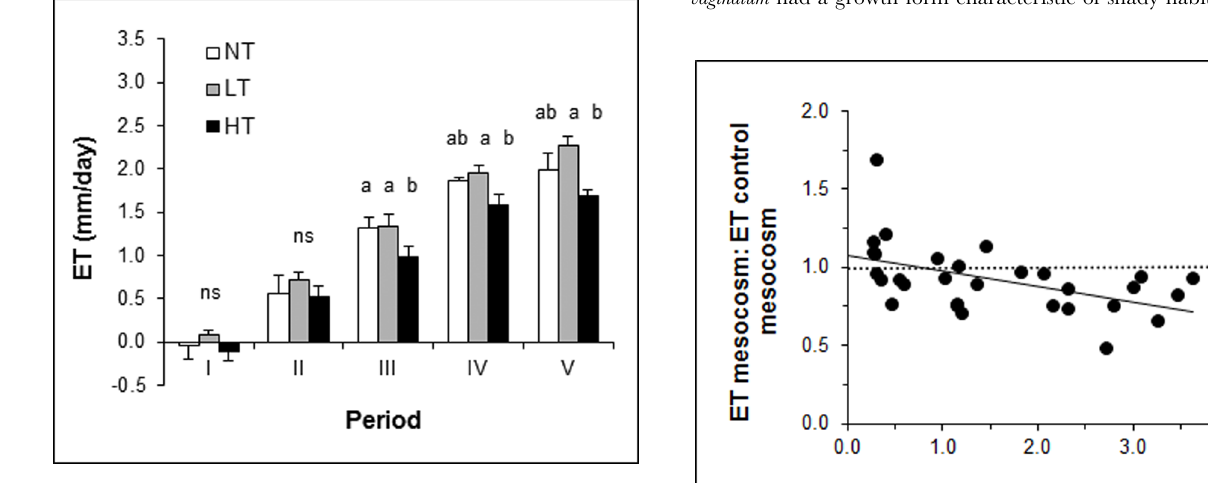
Figure 3. Seasonal changes in tree density effects on meso- cosm evapotranspiration. Bars represent means + 1 SE (n=5) per birch density treatment averaged over periods (I–V) in order of increasing atmospheric demand for water. Periods I and II cover late autumn -early spring, whereas periods III–V represent mid spring-mid autumn (Table 2). Measurements spanned 1 year from week 38 in 2007 until week 37 in 2008, the only year for which we had water table data for all seasons. NT=control without trees, LT=low tree density, HT=high tree density. Different letters above the bars denote statistically significant ( P , 0.05) differences between tree density treatments within a period based on five separate 2-way ANOVAs with treatment as factor and block as random factor, one ANOVA for each period.